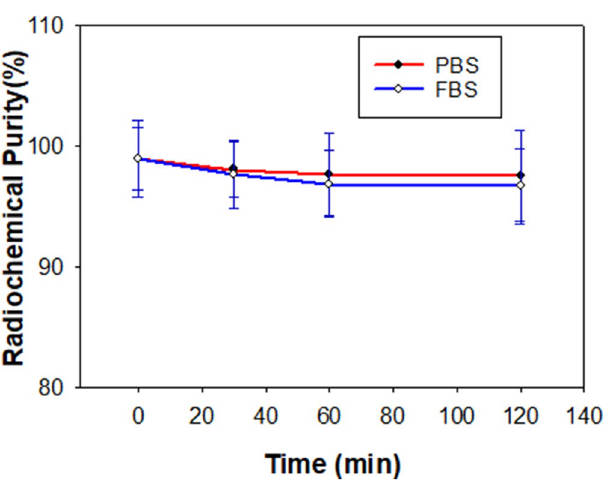
Figure 3. Stability of 68 Ga-SC691. Radiochemical purity was determined in PBS and FBS at 0 min (initial point), 30 min, 60 min, and 120 min.